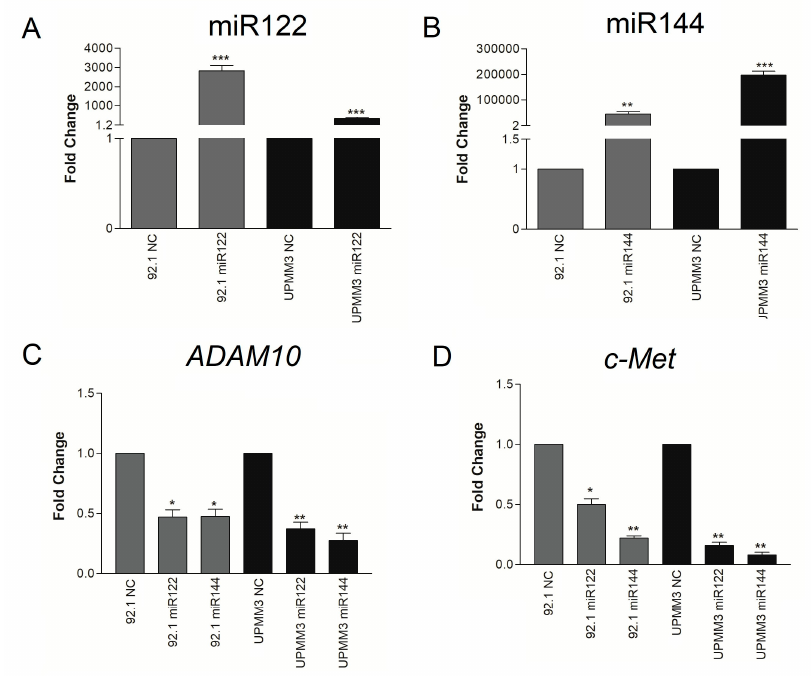
Figure 3. Effects of miR122 and miR144 mimic transfection in UM cell lines. MiR122 ( A ) and miR144 ( B ) expression increases in cell lines 92.1 and UPMM3 when transfected with the corresponding miR mimic. Increments in miR expression ranged from 800- to 197,000-fold, relative to transfection control (irrelevant miR: NC). MiR122 and miR144 mimic transfection inhibit ADAM10 ( C ) and c-Met ( D ) mRNA expression levels, measured by RT-qPCR, in 92.1 and UPMM3 UM cell lines. Results are presented as fold change versus irrelevant miR control (NC) of relative quantification analysis efficiency-method based on miR122 and miR144 targets compared to the U6 internal control. Values are the mean ± sd of RT-qPCR analyses. Consistent data were obtained in two additional experiments (* p < 0.05; ** p < 0.01; *** p < 0.001).